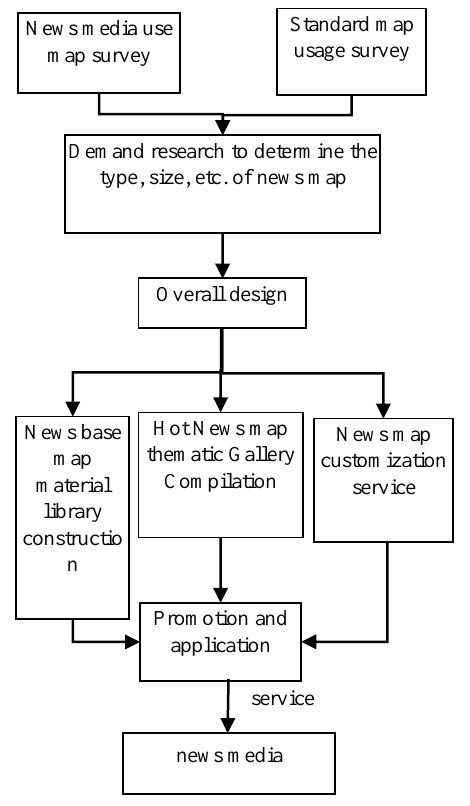
Figure 1. News map compilation service research overall technical flow